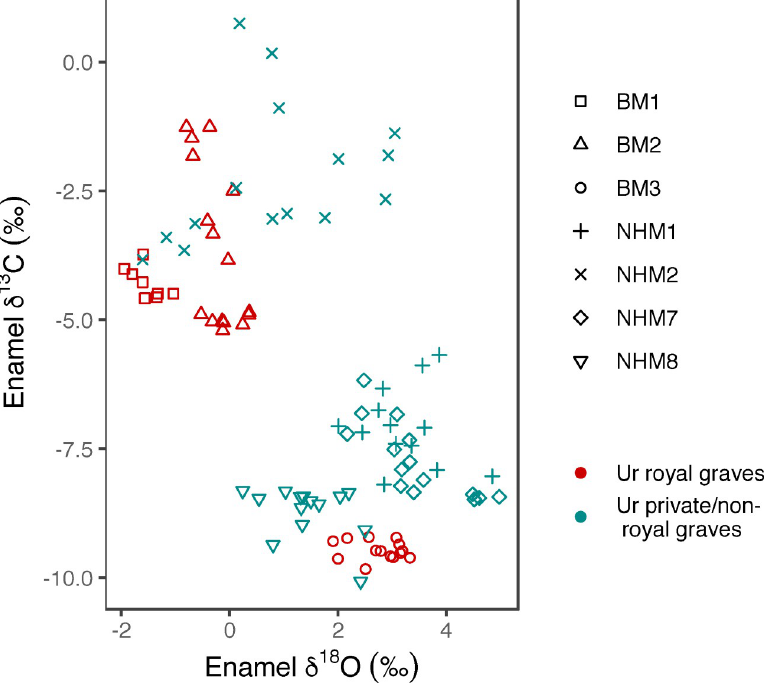
Fig 9. (bovid_OC.eps): Scatter plot of bovine enamel carbonate sub-sample carbon and oxygen isotope values, separated by individual (different shapes) and the royal/private/non-royal graves (different colours).